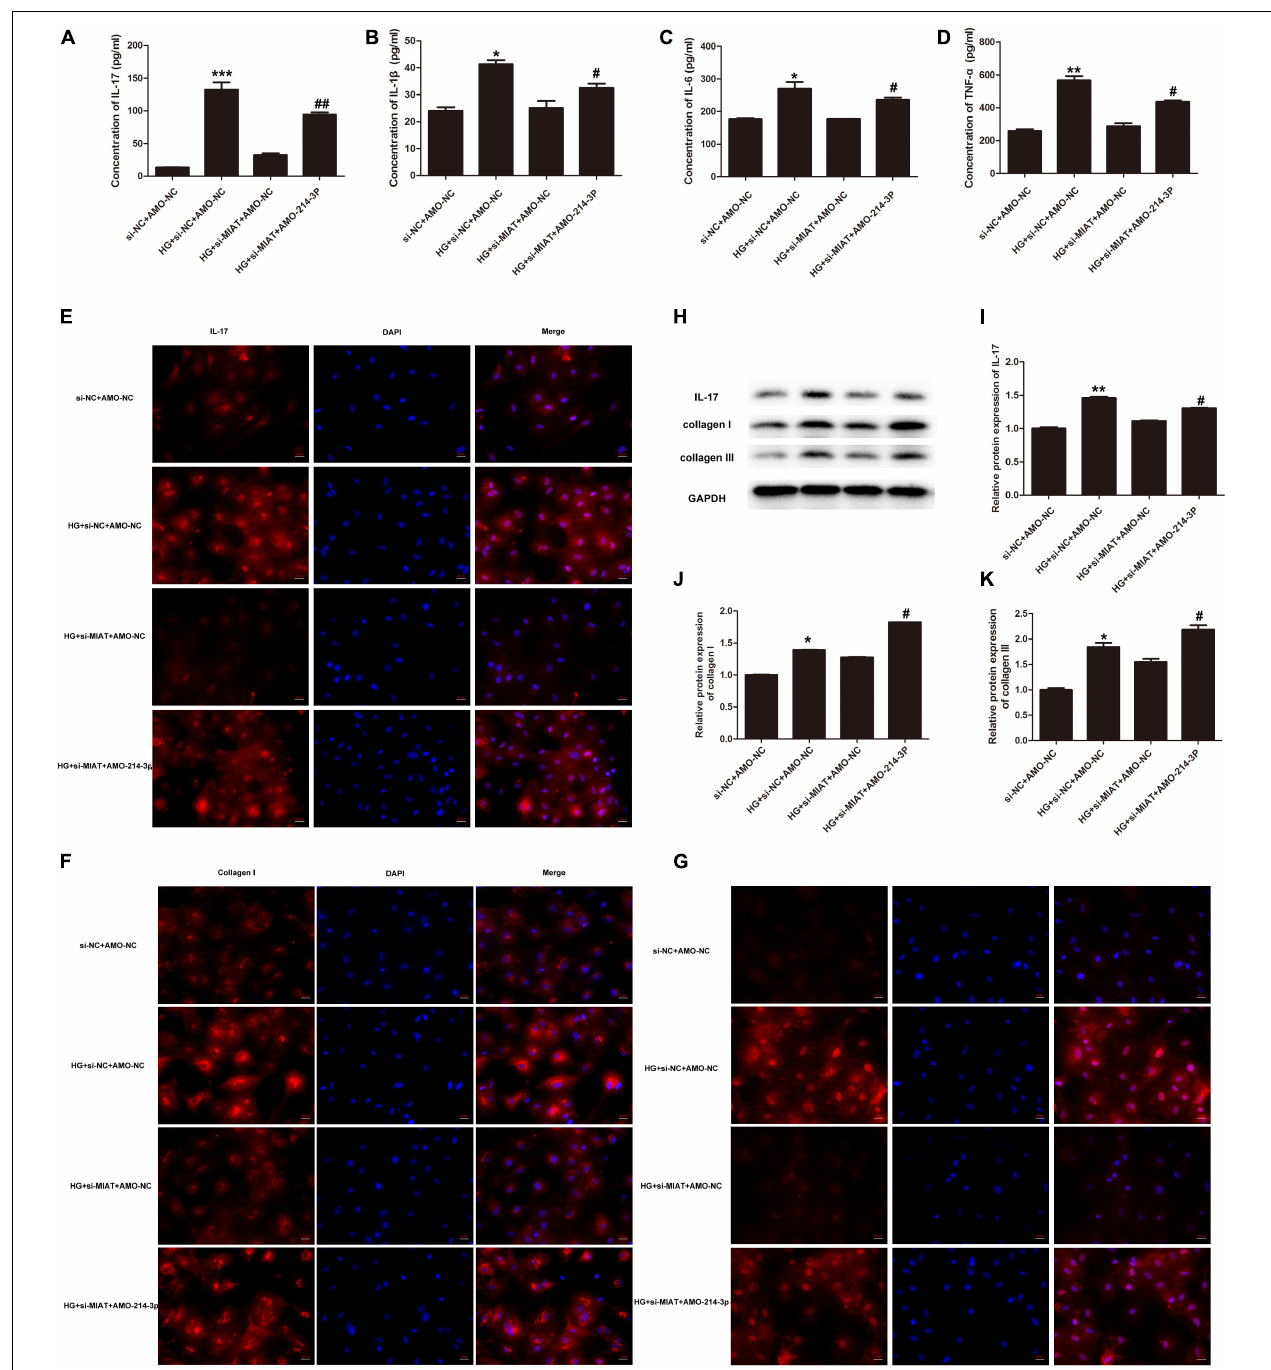
FIGURE 4 | LncRNA-MIAT-mediated miR-214-3p regulates fibrosis in cardiomyocytes. (A–D) Cell supernatants were collected from primary cardiomyocytes culture under different treatments as indicated. The protein levels of IL-17, IL-1 β , IL-6, and TNF- α were detected using ELISA kits, * p < 0.05, ** p < 0.01, *** p < 0.001 (between si-NC + AMO-NC and HG + si-NC + AMO-NC); # p < 0.05, ## p < 0.01 (between HG + si MIAT + AMO-NC and HG + si MIAT + AMO-214-3p). (E–G) Immunocytochemical staining was conducted using anti-IL-17 (red), anti-collagen I (red), and anti-collagen III (red), respectively, in primary cardiomyocytes under different treatment groups as above-mentioned. Nuclei were counterstained by DAPI (blue). Scale bars, 20 µ M. (H–K) Cell lysates of primary cardiomyocytes with above-mentioned treatments were collected and processed for western blotting to examine the protein expression of IL-17, collagen I, and collagen III, respectively, as Figure 2B mentioned. Densitometric analysis was also performed as described in Figure 2B ; * p < 0.05, ** p < 0.01 (between si-NC + AMO-NC and HG + si-NC + AMO-NC); # p < 0.05 (between HG + si MIAT + AMO-NC and HG + si MIAT + AMO-214-3p).